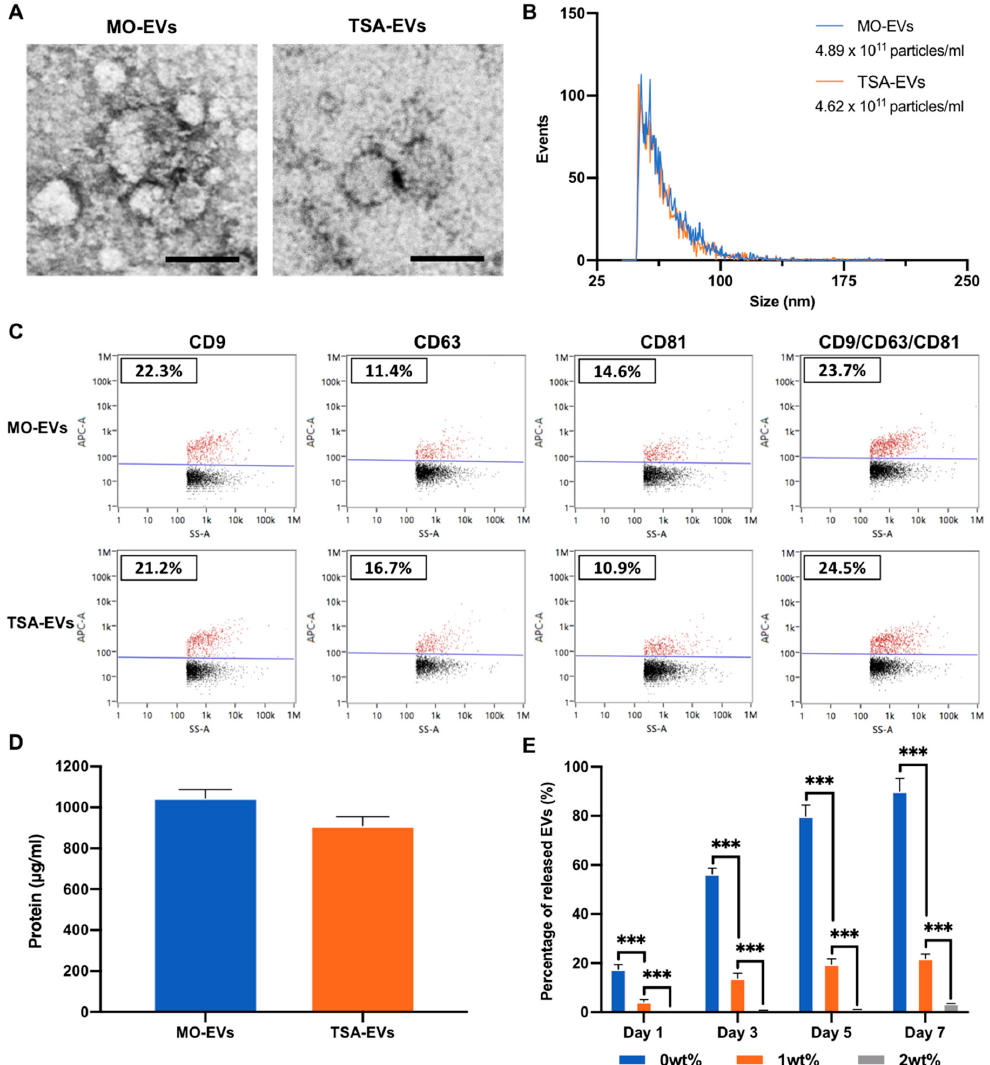
Figure 4. Characterisation of EVs derived from TSA treated and untreated mineralising osteoblasts. ( A ) TEM image of isolated EVs. Scale bar = 50 nm. ( B ) Nano-flow cytometry (NanoFCM) analysis, depicting the size distribution and concentration of particles. ( C ) Single-particle phenotyping of osteoblast-derived EVs. EVs were fluorescently labelled with APC-conjugated antibodies specific to CD9, CD63 and CD81. Bivariate dot-plots of indicated fluorescence versus SSC are shown. In addition, CD9/CD63/CD81 positive particles are shown. ( D ) EV protein content. ( E ) Quantification of EVs released from GelMA hydrogel with/with LAP assessed via CD63 positive ELISA. Data are expressed as mean ± SD ( n = 3). *** p ≤